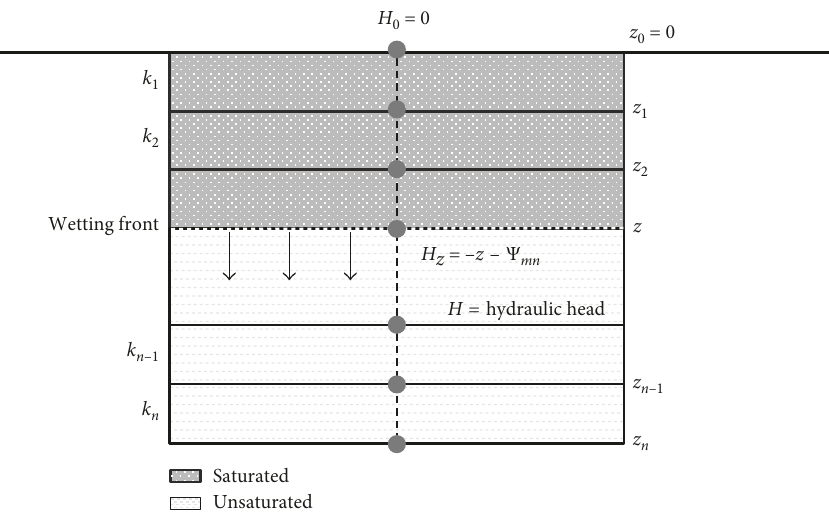
Figure 1: Infiltration into a layered soil profile under an initially ponded condition.